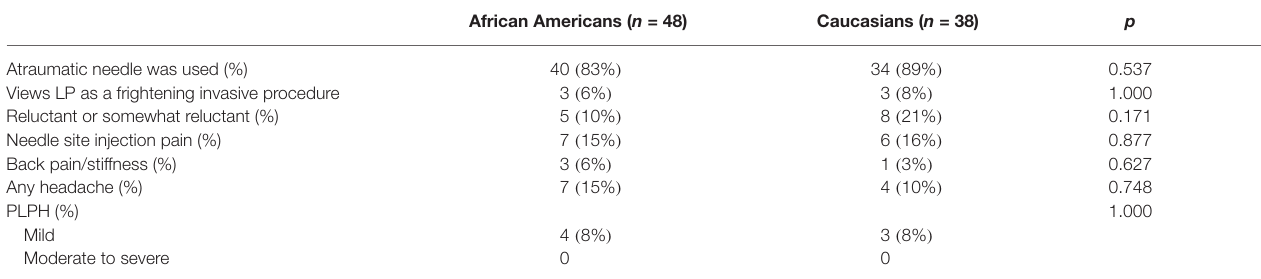
TABLE 3 | Technical factors and discomfort and complications associated with LPs among survey respondents. African Americans ( n =